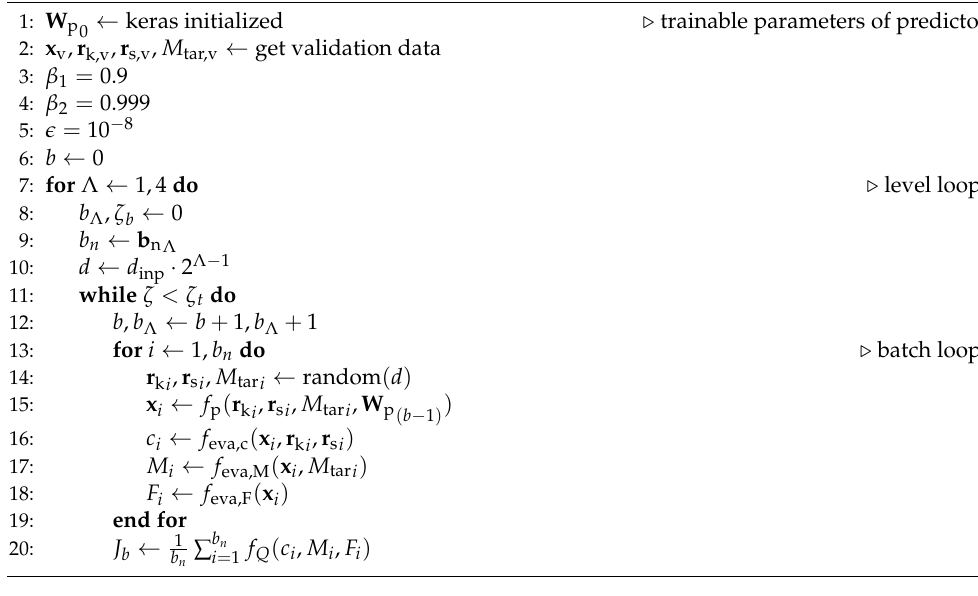
Algorithm 1 Learning process, Part 1 (training)